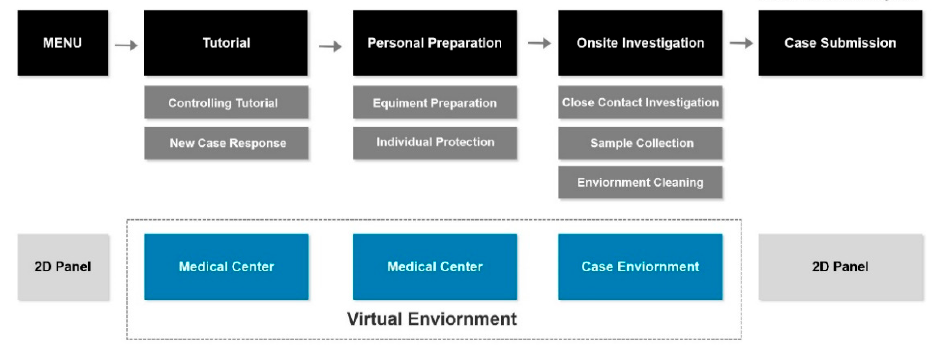
Figure 3. COVID-19 Education System Structure.